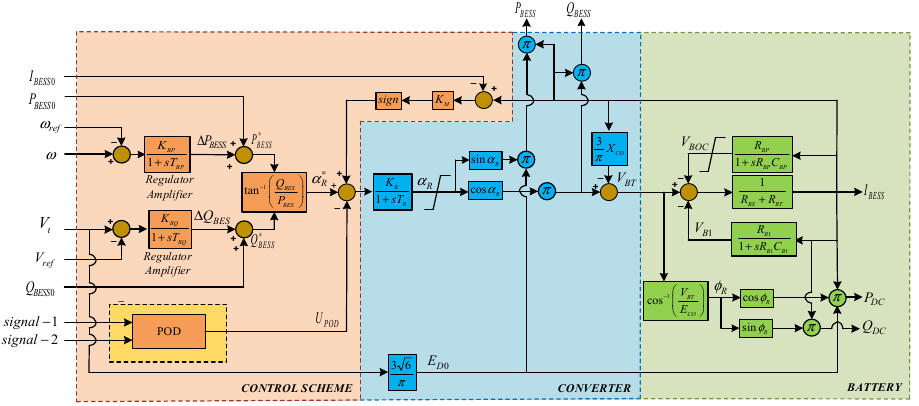
Figure 2. Dynamic model of BESS.